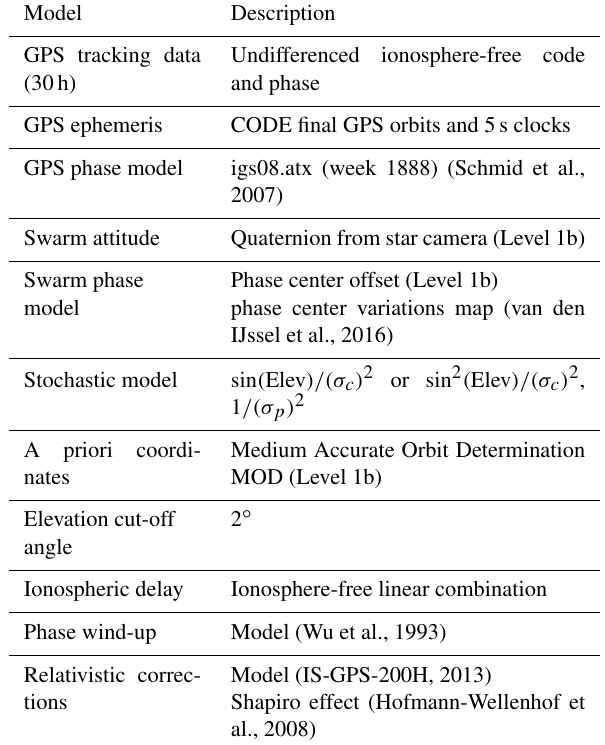
Table 3. Summary of the measurement and error models used for Swarm kinematic orbit